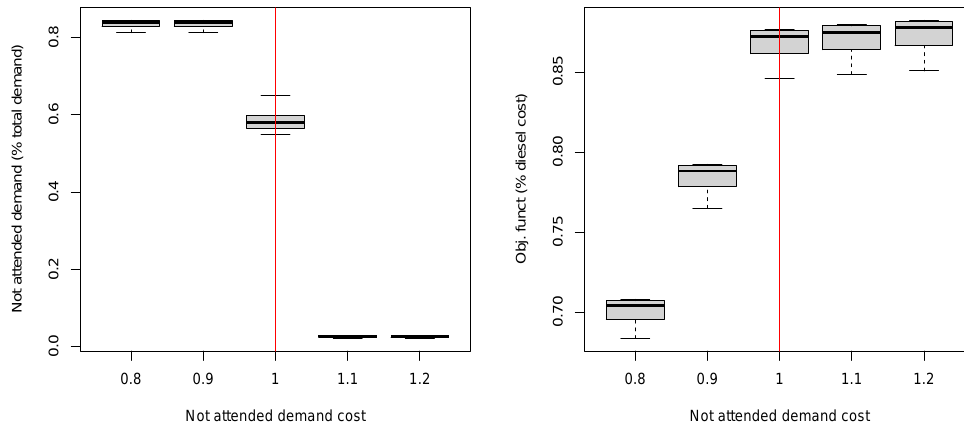
Figure 5. Impact of the penalty to unmet